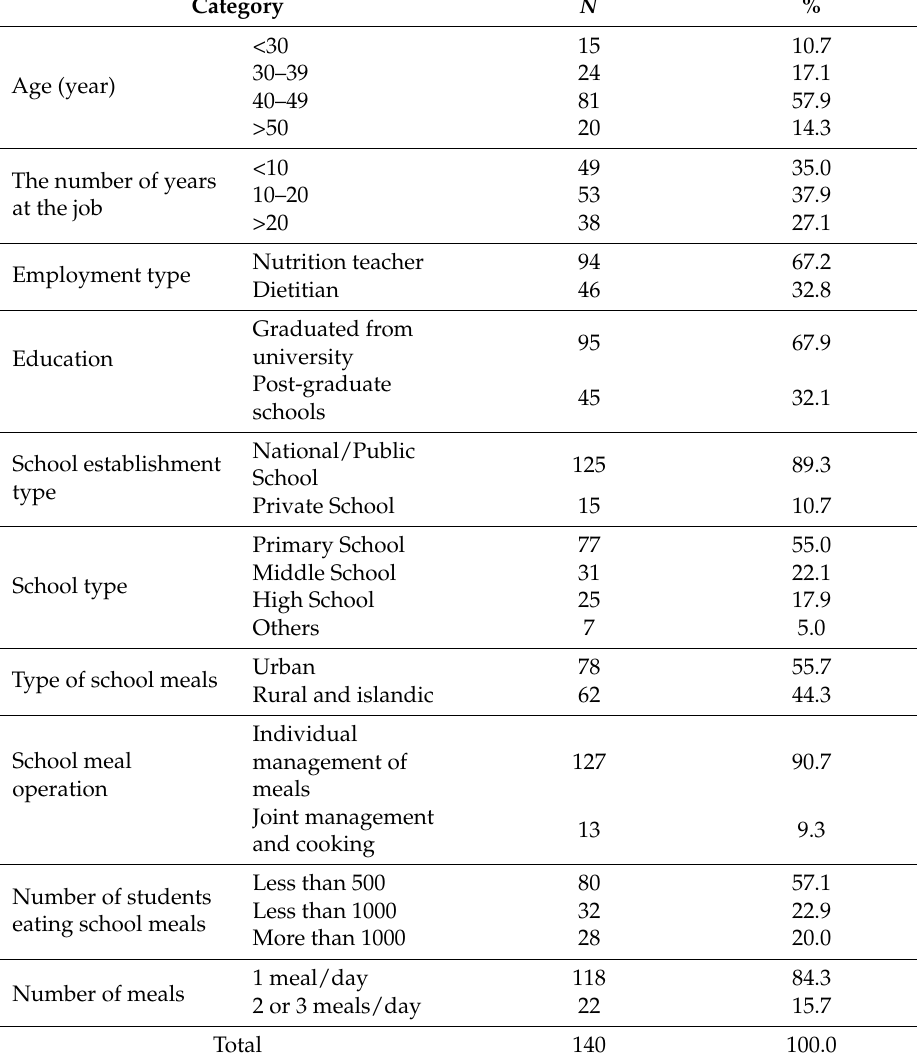
Table 1. Demographic characteristics and workplace characteristics of